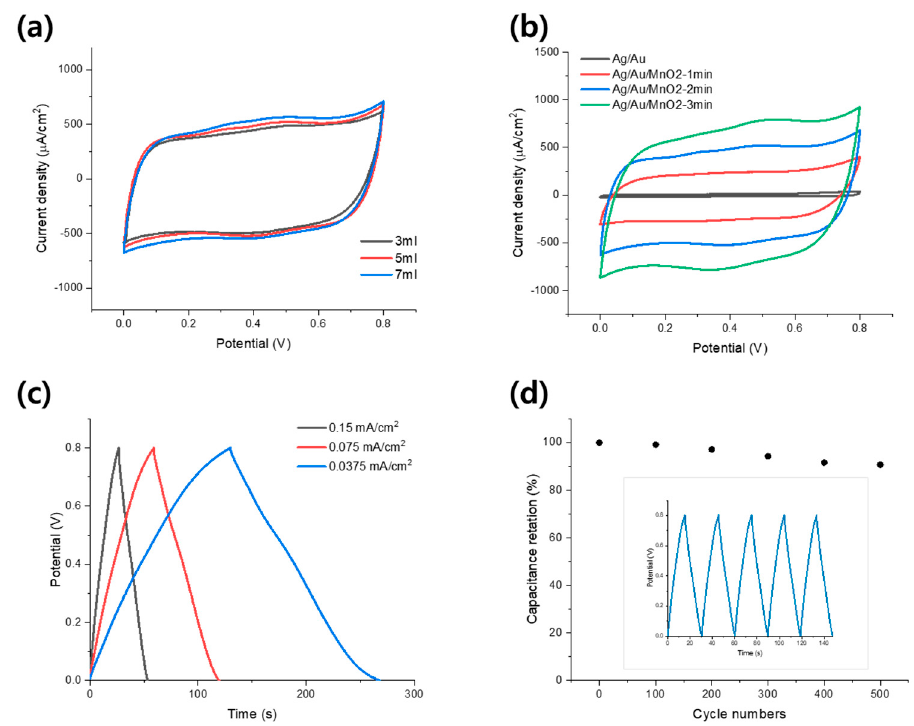
Figure 5. Electrochemical performances of the Ag/Au/MnO 2 core − shell NW network electrodes. ( a ) CV curves of Ag/Au/MnO 2 core − shell NW electrodes with different areal densities of AACS NW at 100 mV/s voltage scan rate. ( b ) CV curves of the electrodes prepared through various coating times (from 0 to 3 min). Here, the CV curve of the AACS NW (black line) was obtained from the 50th CV cycle (same data with the Figure 3c). ( c ) Charge − discharge curves of the Ag/Au/MnO 2 core − shell NW electrode with different current densities. ( d ) Cyclic stability of the Ag/Au/MnO2 core − shell NW electrode in a continuous charge − discharge test at a 0.2 mA cm − 2 current density.